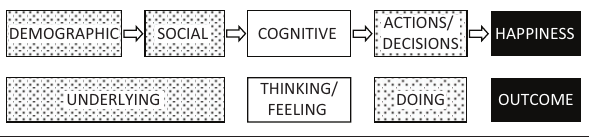
FIGURE 6: Path of influence postulated for this